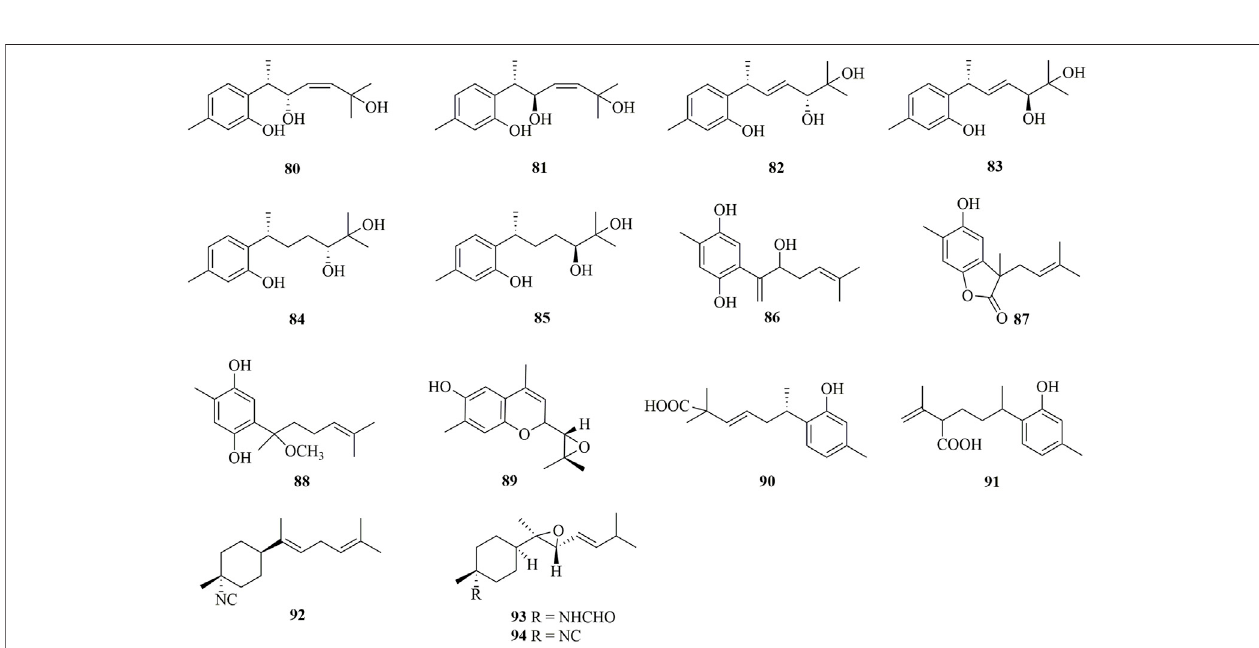
FIGURE 7 | Bisabolanes characterized from marine sponges ( 80 – 94